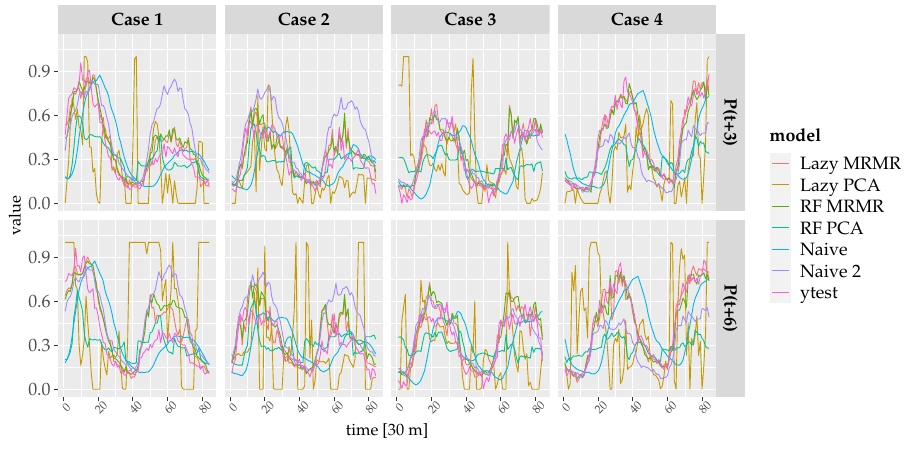
Figure 9. Visualization of actual ( ytest ) and predicted load trajectories for a 3 h forecasting horizon.